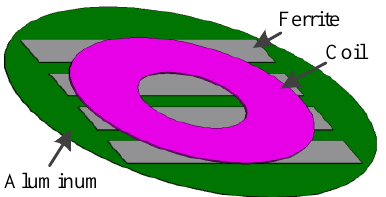
Figure 3. Structure of the secondary side.